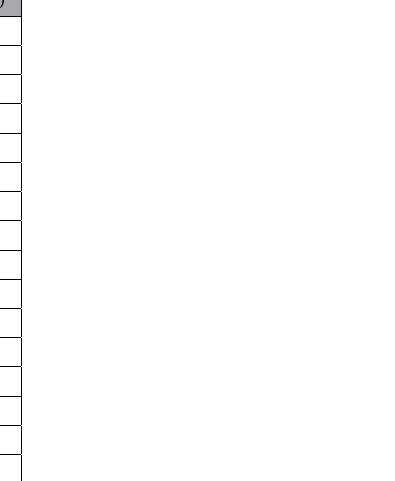
Table 1. Decay times by frequency and duty